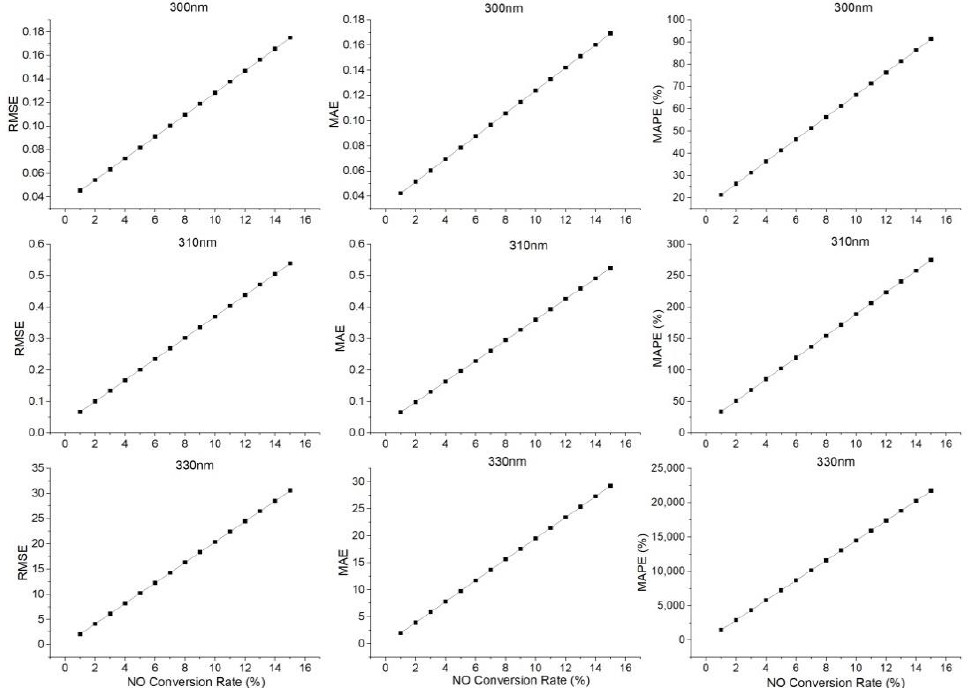
Figure 6. Single-wavelength simulation analysis results for different NO conversion rates at different wavelengths.